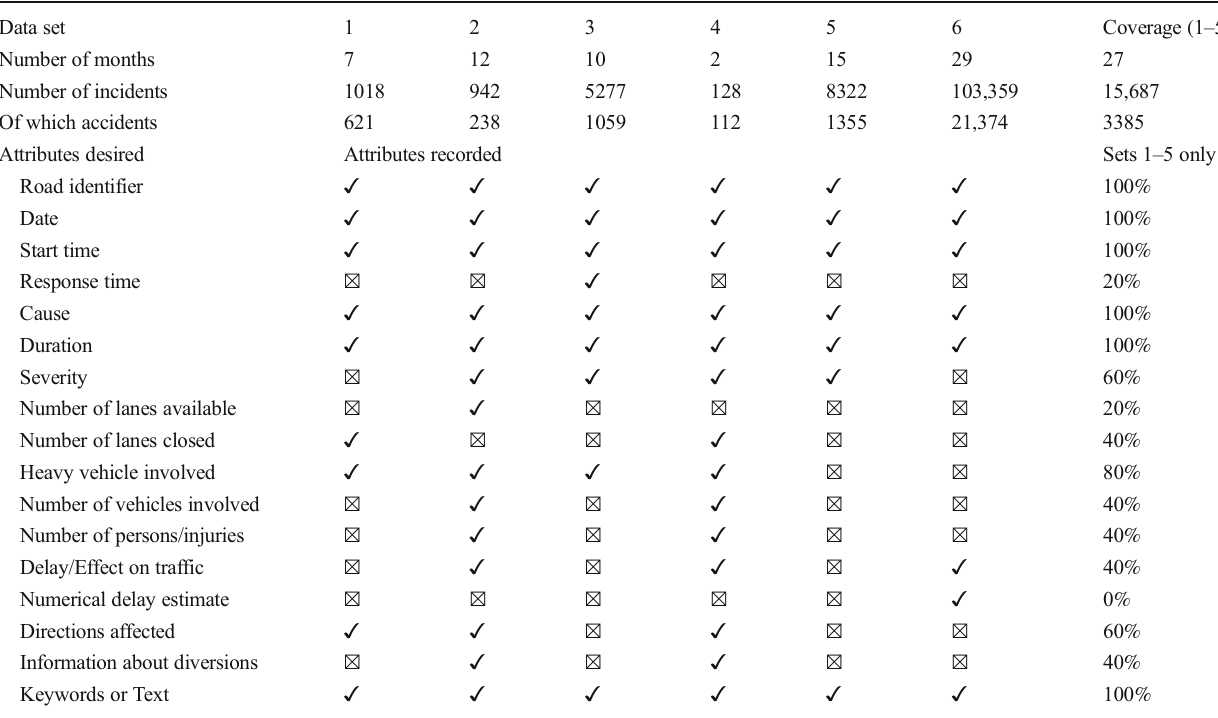
Sample incident datasets with breakdown of attributes recorded and